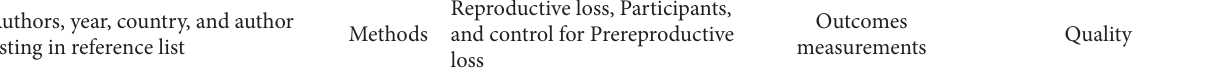
Table 1: Characteristics of included studies for TOP (a) and TOP with miscarriage/perinatal loss/neonatal death